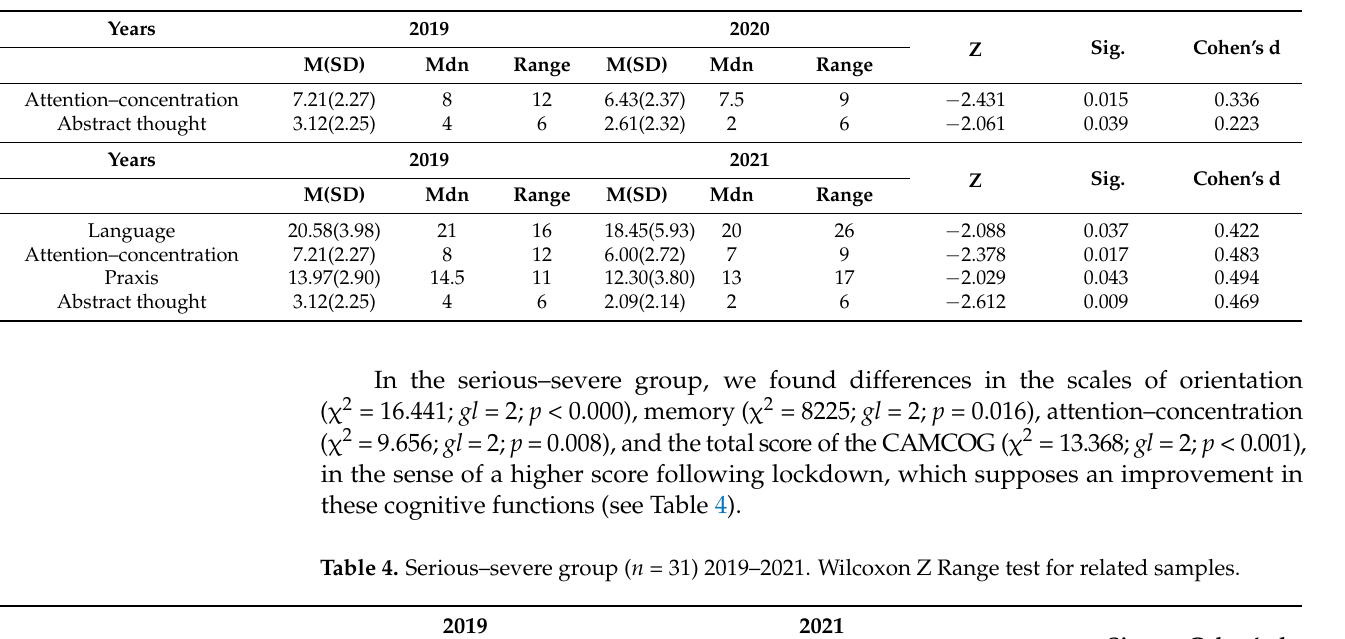
Table 3. Light–moderate group ( n = 61). 2019–2020/2019–2021. Wilcoxon Z Range test for related samples.